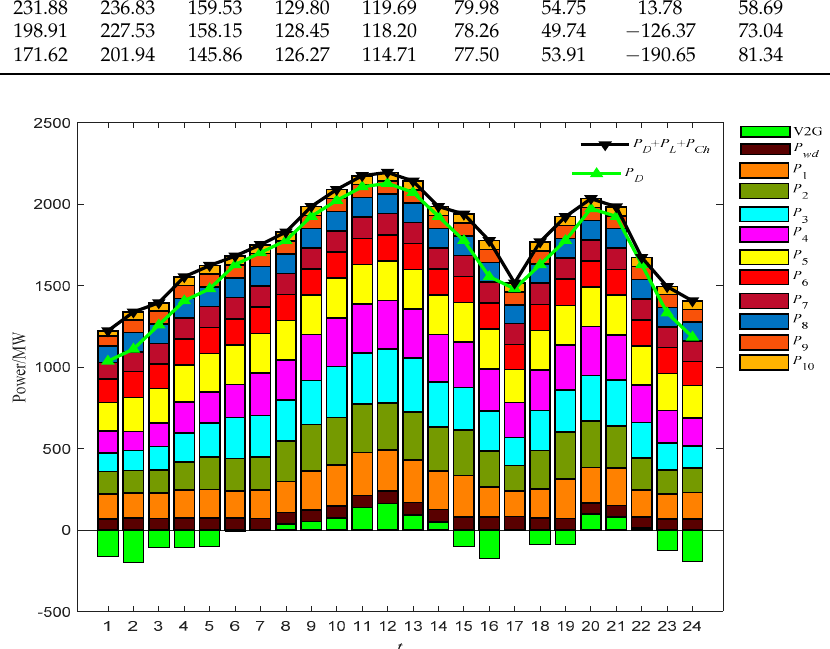
Figure 4. Constraints checking for the best compromise solution.